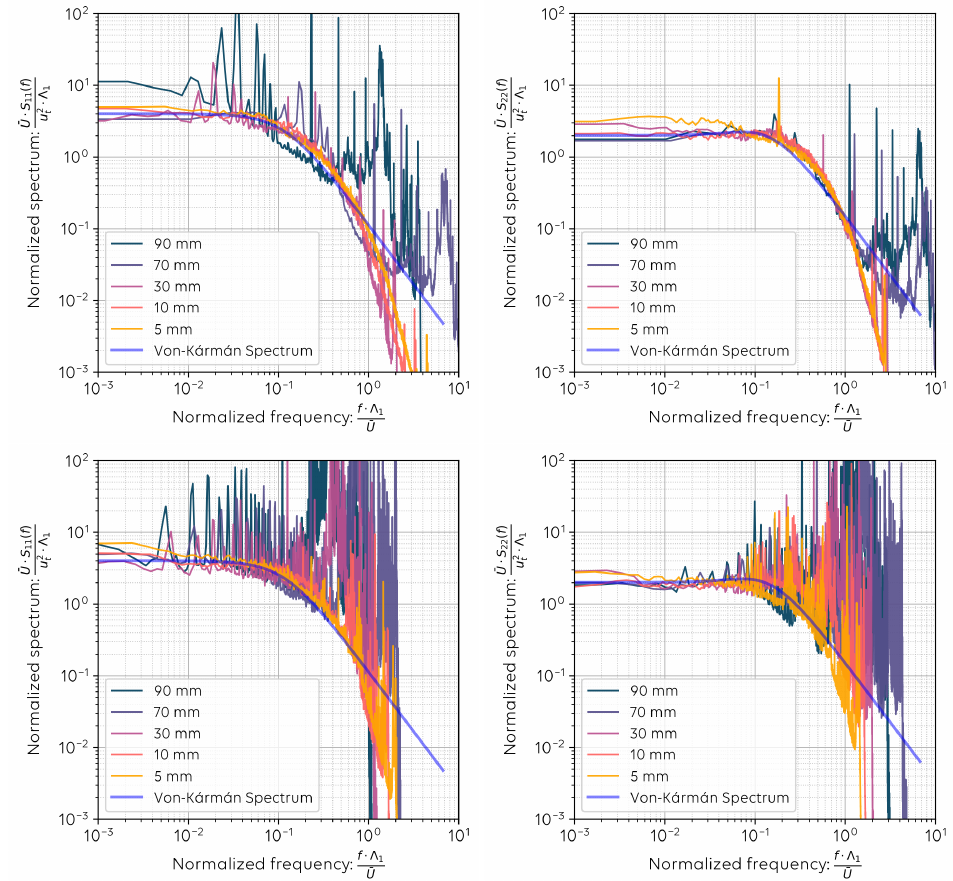
Figure 12. Results obtained for five chosen measurement positions and two fan speeds. Numbers in the label refer to the distance from the duct wall (probe insertion depth). Spectra are normalized by the estimated parameters u 2 , Λ 1 and U 0 . A von Kármán spectrum is also plotted as a reference. Top plots: η 1 ≈ 3800 RPM. ( Bottom plots ): η 2 ≈ 6840 RPM. ( Left plots ): Longitudinal velocity component. ( Right plots ): Transverse velocity